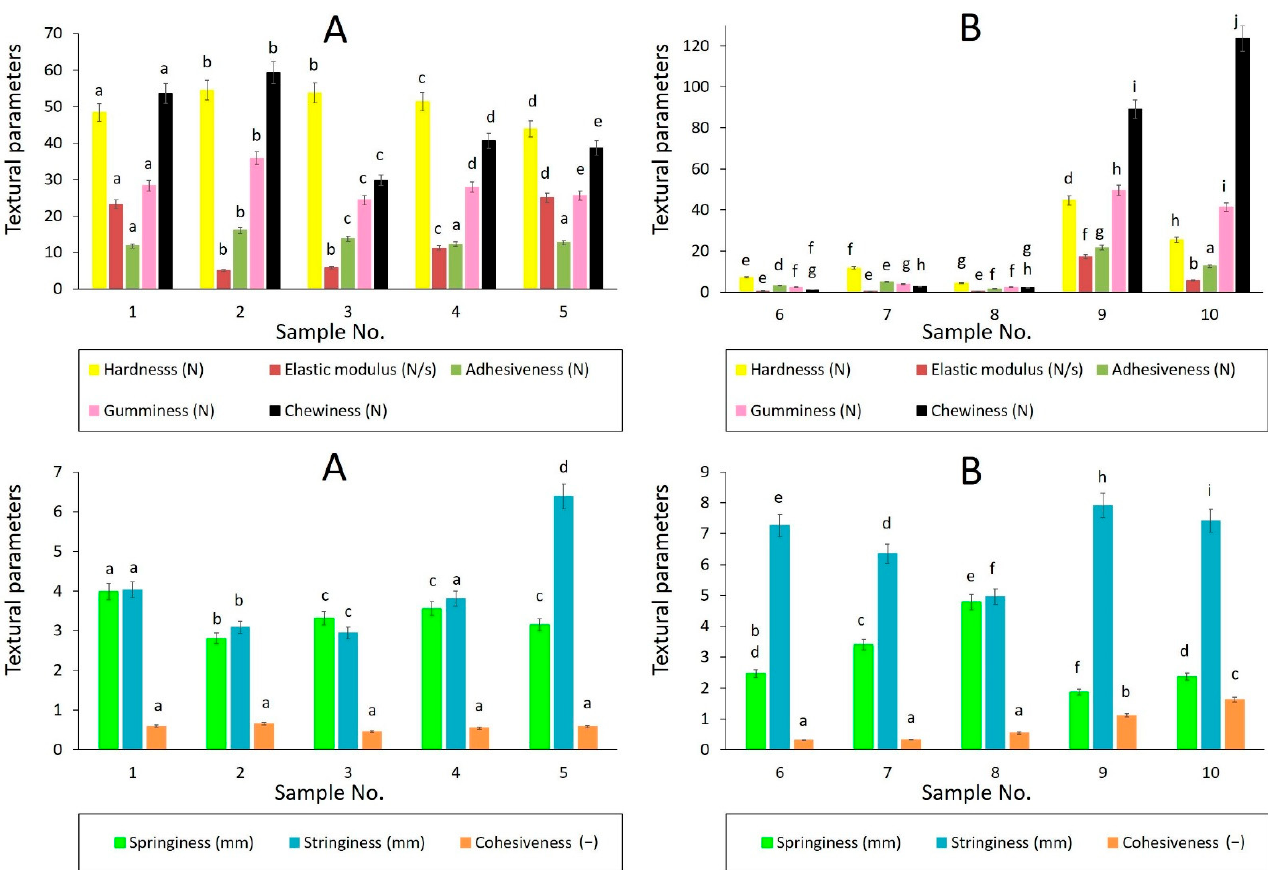
Figure 1. Texture profile analysis of butters ( A ), spreadable fats, and shortenings ( B ) using 5 mm distance penetration test (bar chart with 5% error bars). Textural parameters are described in the legend with the relevant units in the brackets; adhesiveness is expressed in absolute values. Different superscript letters for the same textural parameter indicate statistically significant differences between the samples ( α ≤ 0.05, Tukey test).